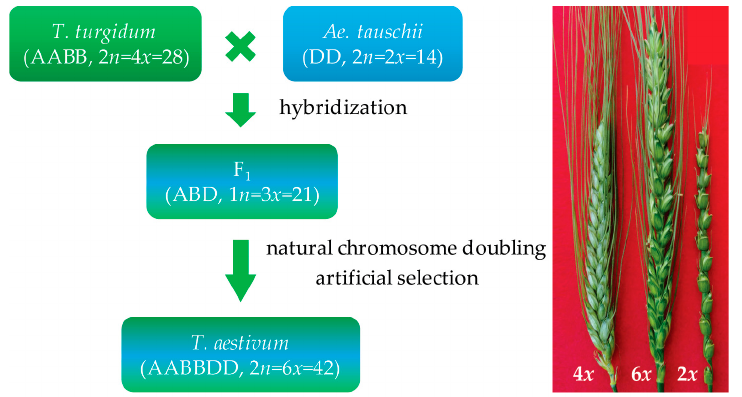
Figure 1. Hexaploidization and artificial synthesis of wheat.